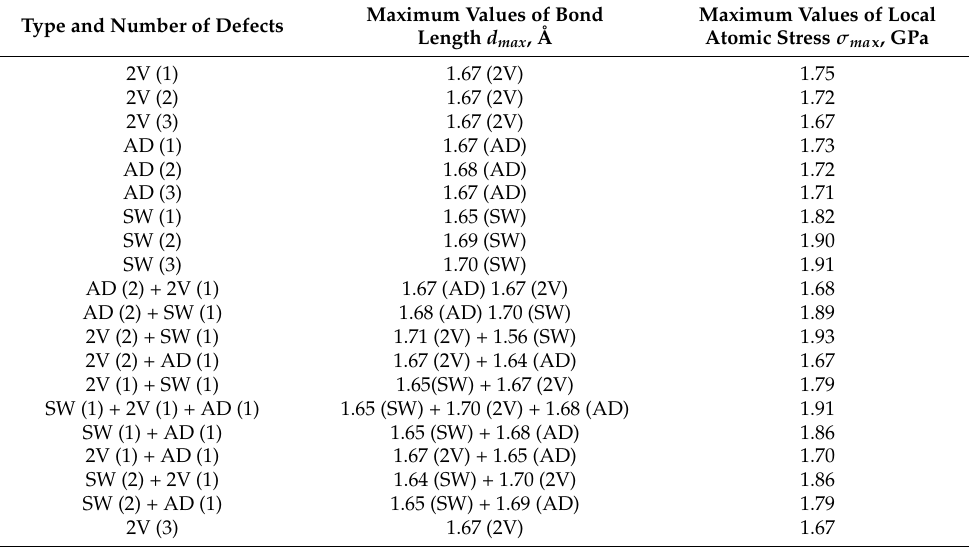
Table 1. Characteristics of investigated graphene